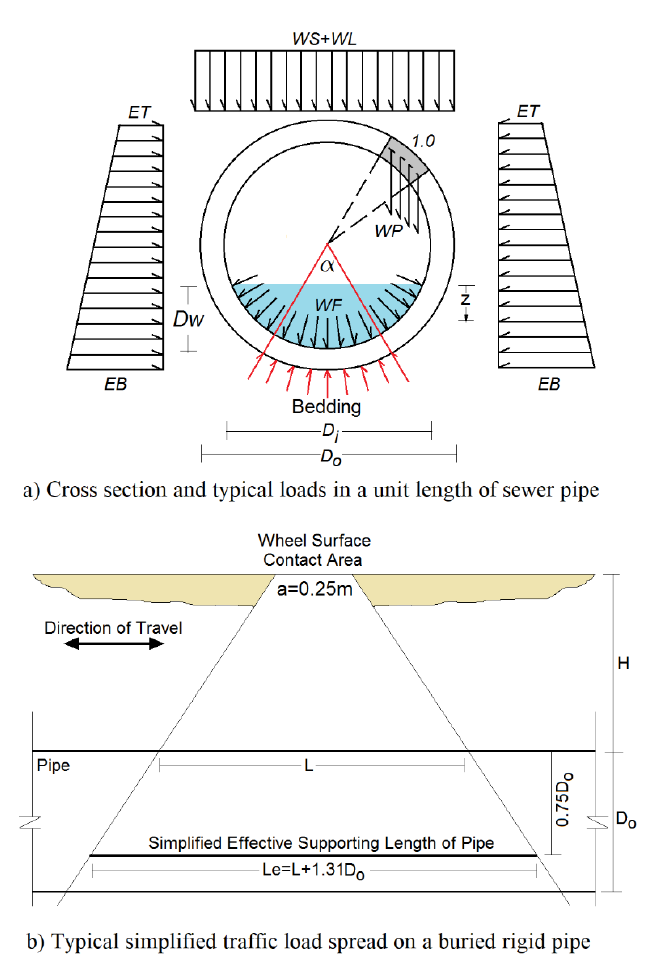
Figure 1. Typical loads demanding a buried sewer pipe (based on information available in